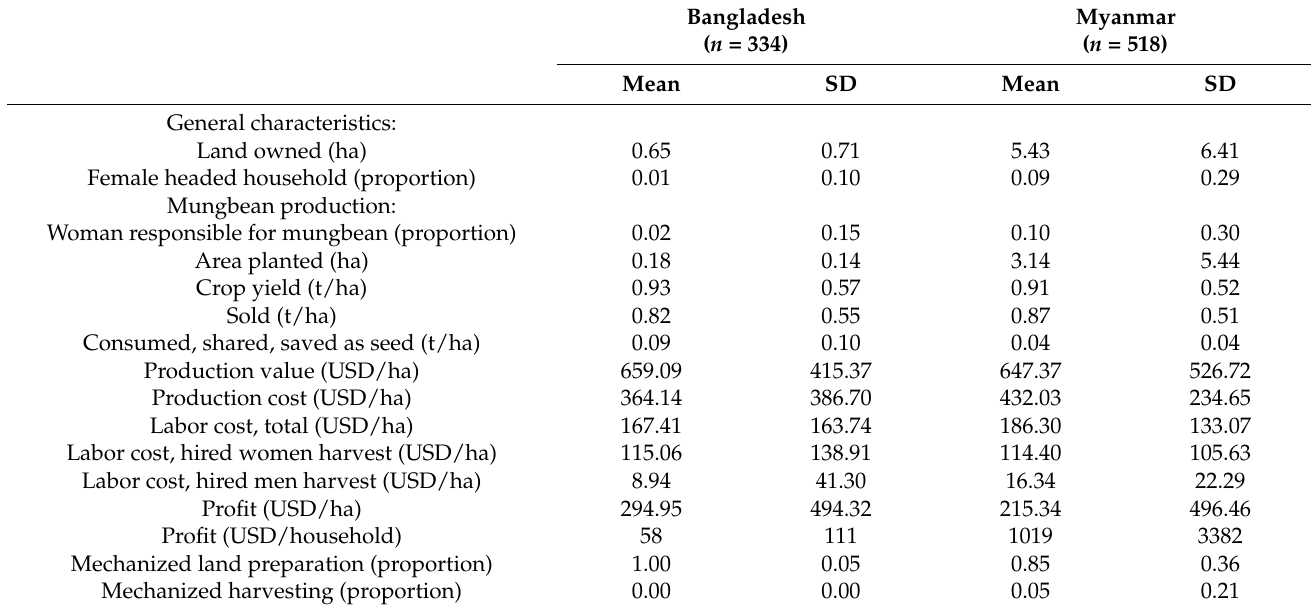
Table 3. Sample characteristics of mungbean producing households in Bangladesh and Myanmar, 2019.